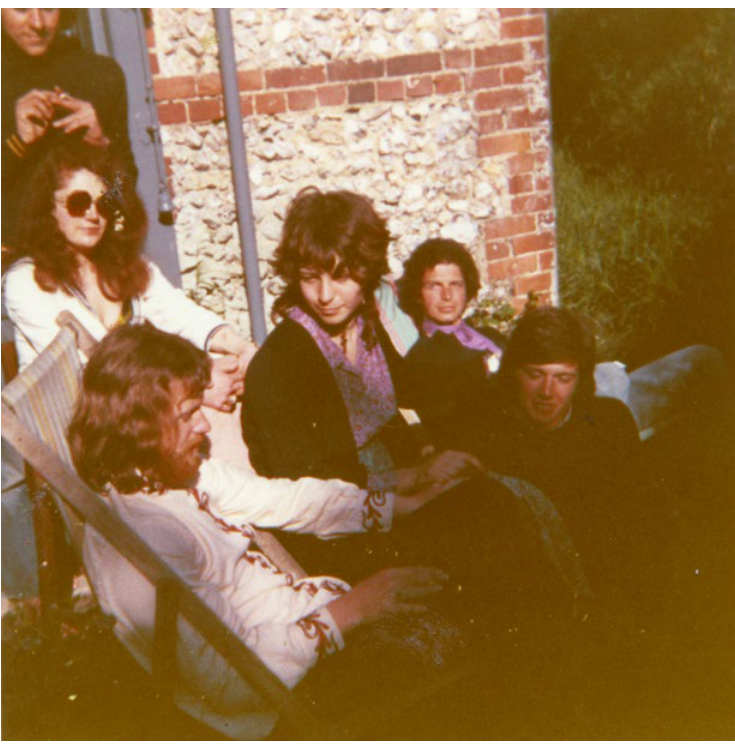
Figure 7.2 The ‘Chaldon Chorale’. Left to right: unidentified young man smoking, Tinch Minter (in dark glasses), Matthew Davis, Jane Shrubsall, Robert Shrubsall, Piers